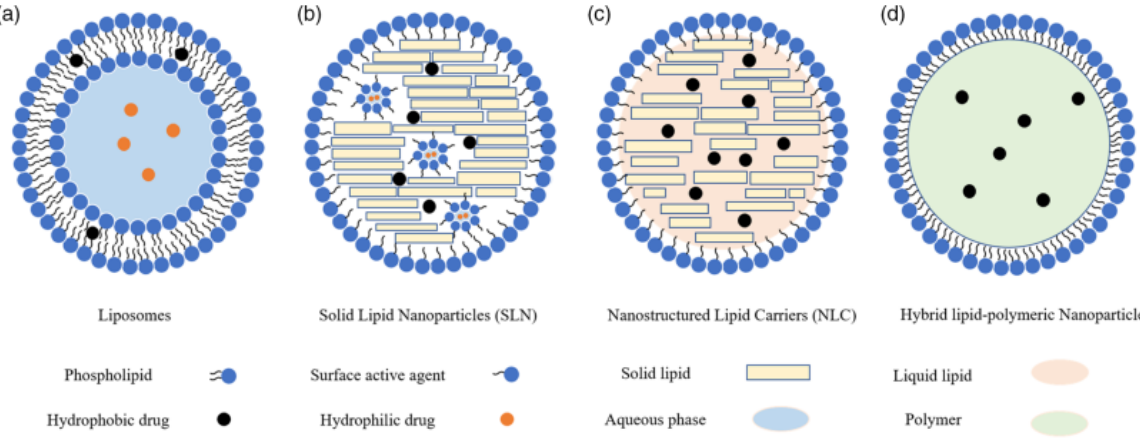
Figure 2. Different types of LNPs. Adopted from ref. [30], Adv. NanoBiomed Res. 2022.